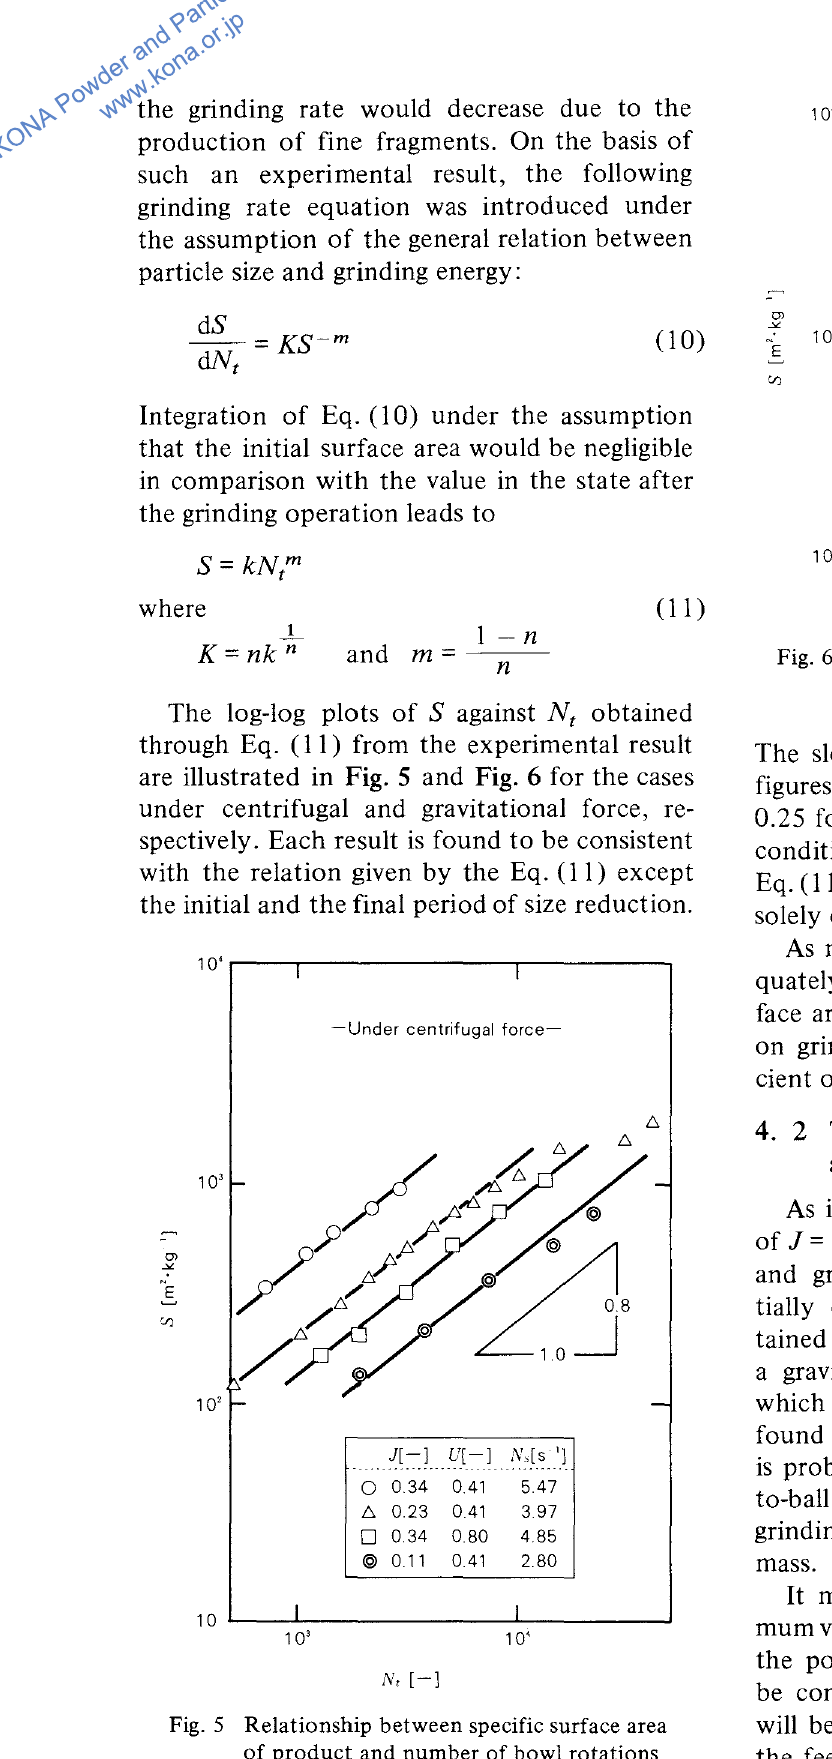
Fig. 5 Relationship between specific surface area of product and number of bowl rotations